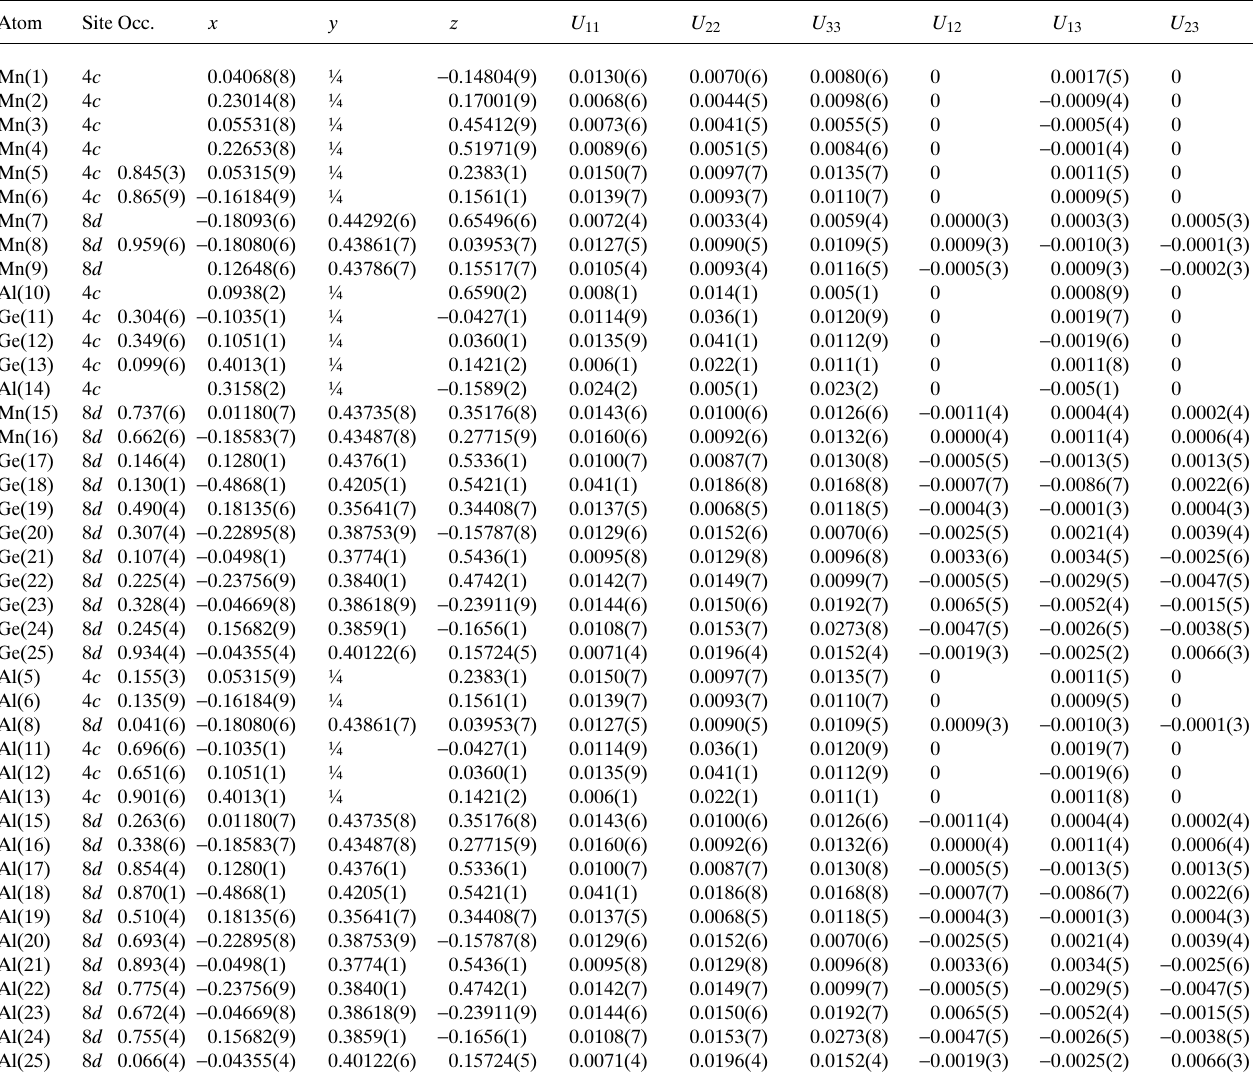
Table 2. Atomic coordinates and displacement parameters (in Å 2 ) .